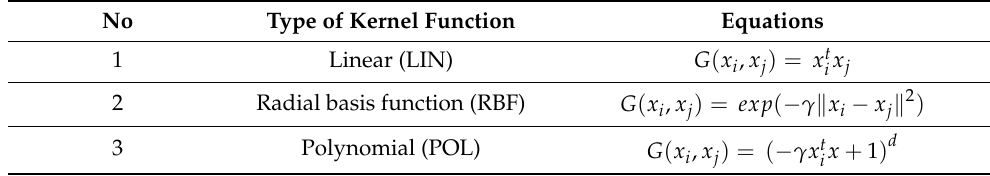
Table 3. Equations of different kernel functions. No Type of Kernel Function Equations